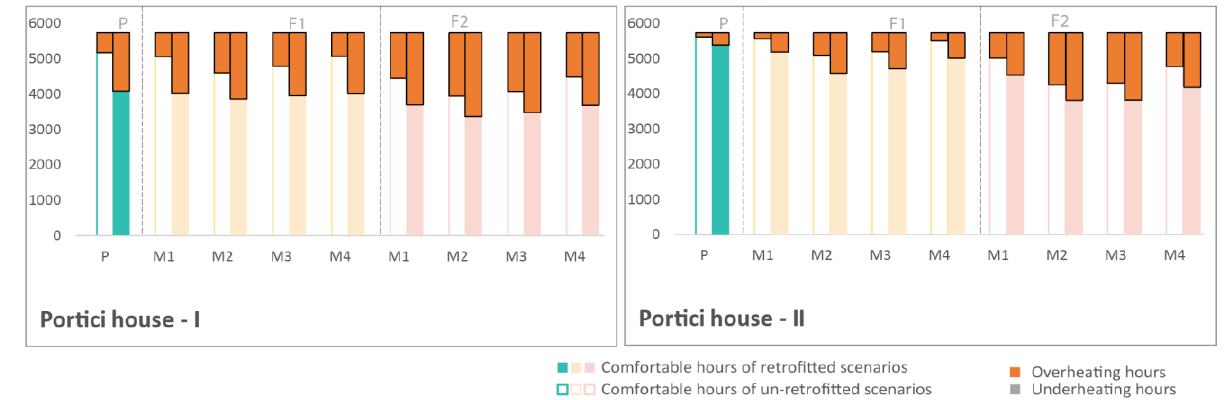
Figure 10. Thermal comfort assessment in the Livingroom (LR) of Portici house-I ( left ) and Portici house-II ( right ) according to CIBSE A. P = 2008 – 2018, F1 = 2041 – 2050, F2 = 2091 – 2100; M1-4, refer to the climate models in Table 2.